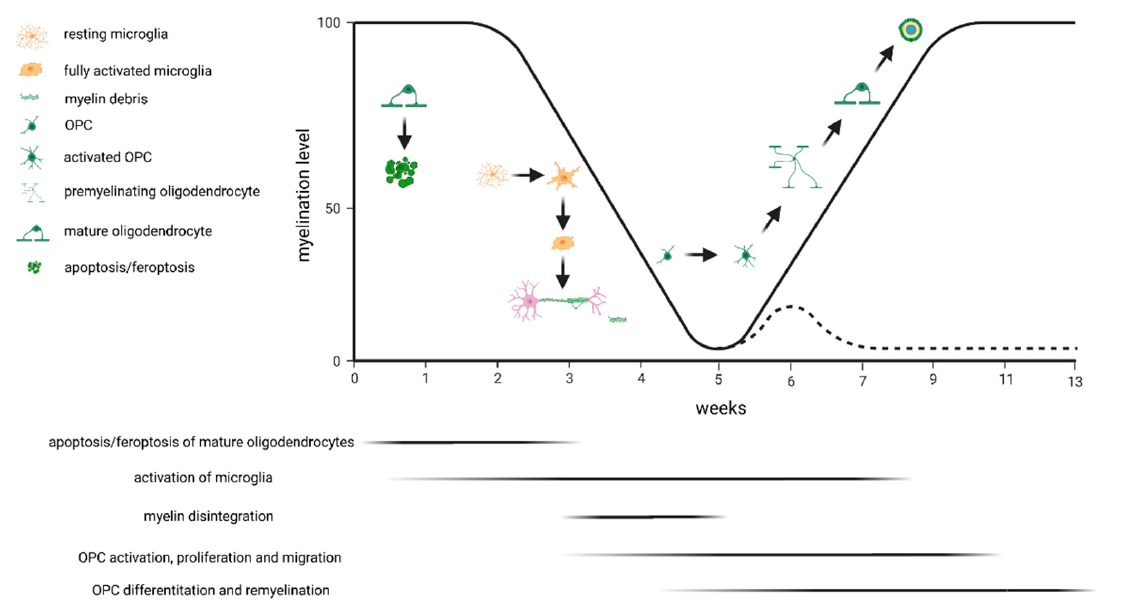
Figure 1. Schematic presentation of the cuprizone-induced pathological changes. The black line indicates the percentage of myelinated fibers in the corpus callosum above the fornix during acute exposure to cuprizone. The dashed line indicates exposure to cuprizone for 13 weeks (i.e., chronic demyelination). The major event at week 1 is apoptosis/feroptosis of the mature oligodendrocytes. In a second step, this triggers the activation of microglia and astrocytes, both phagocytosing the degenerating myelin sheaths. Oligodendrocyte progenitor cells (OPCs) become activated and start to proliferate. If animals are provided normal chow after acute cuprizone-induced demyelination, endogenous remyelination occurs (solid black line) by OPC differentiation and remyelination. If, however, the cuprizone intoxication is continued, remyelination fails (dashed line).